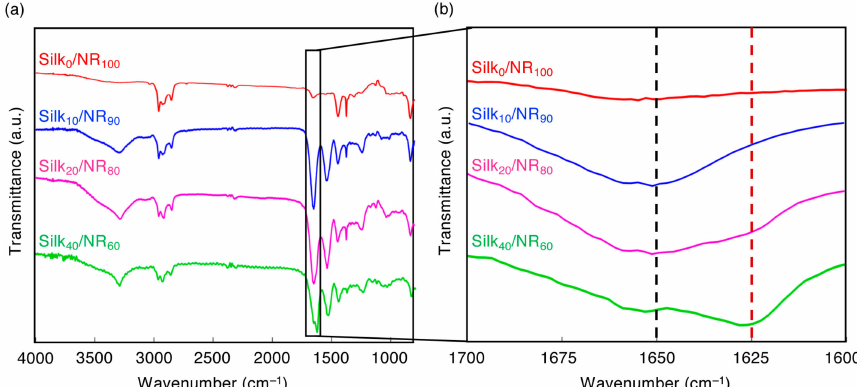
Figure 6. ATR-FTIR spectra of silk / NR composites with di ff erent silk contents in the range of ( a ) 4000–800 cm –1 and ( b ) 1700–1600 cm –1 . The black dotted line (1650 cm − 1 ) represents amide I absorption of the random coil structure of silk, while the brown dotted line (1625 cm − 1 ) represents that of the β -sheet structure [54].